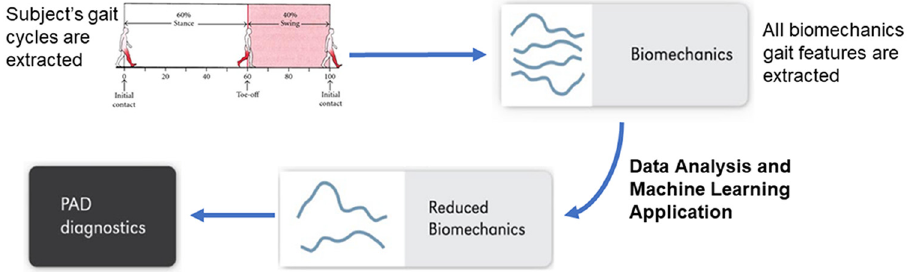
Figure 1. A flowchart briefly describing the utilized data and the methods applied.